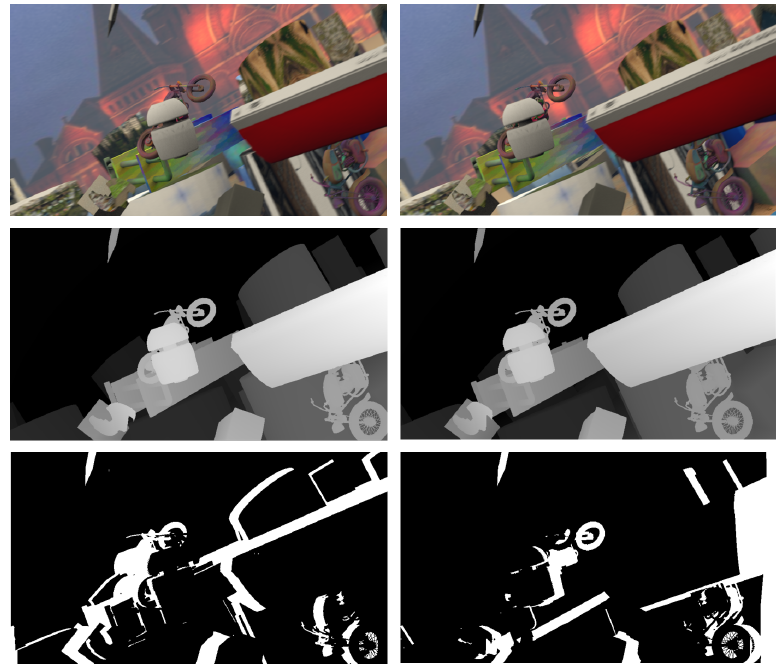
Figure 12. Elements in the DispNet/FlowNet2.0